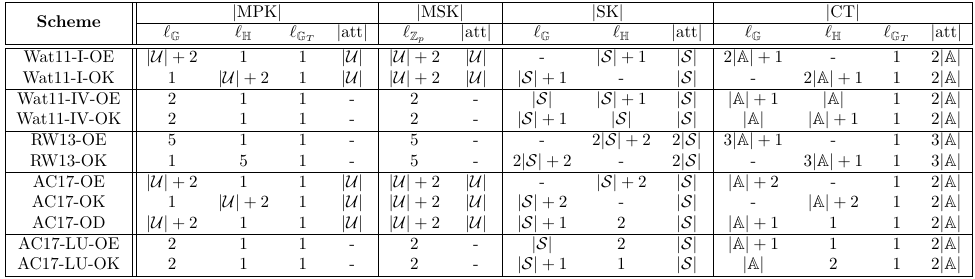
Table 6: The analysis of the memory footprint for all implemented schemes and optimiza- tion approaches (OA). Table 6a lists the general storage costs of the master public key MPK, the master secret key MSK, the secret key SK, the set S , and the ciphertext CT, where | att | denotes the length of a single attribute (in our implementations: att ∈ Z p ), A denotes the policy length, |S| denotes the set size, and ‘ G 0 denotes the length of a single element in group G 0 . Based on this and the rest of our analysis, Table 6b provides upper bounds on the memory consumption for the BLS12-381 and BN446 curves, where we distinguish the regular costs (R) from the precomputation tables (P) and the total costs